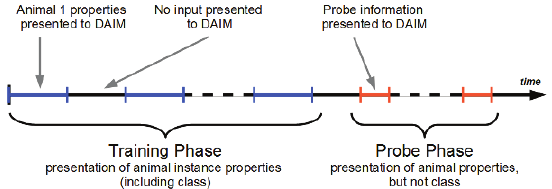
Figure 3. Training and testing DAIM: a sequence of animal instances are pre- phase), separated by periods of no input. sented to DAIM ( During the Training Probe